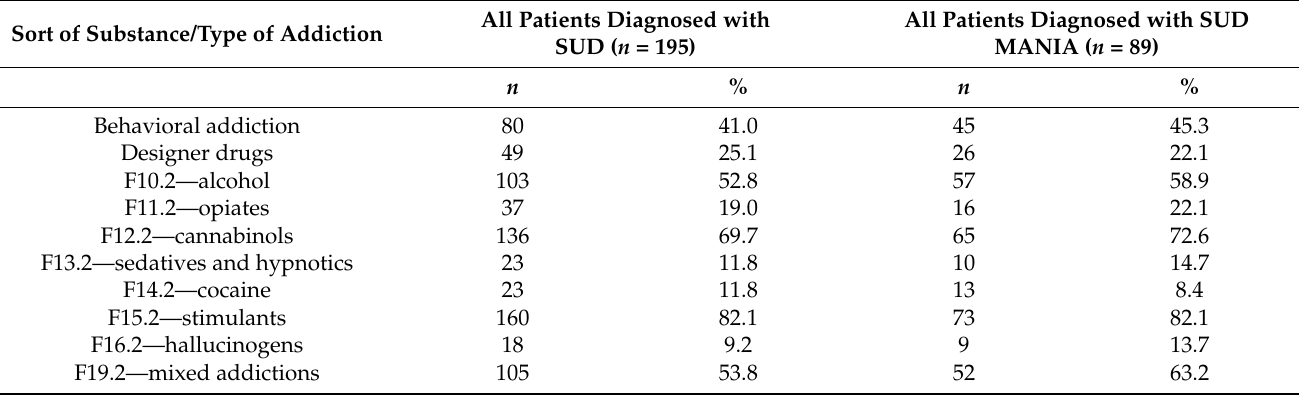
Table 1. The sorts of psychoactive substances used in all addicted subjects under